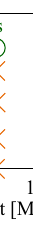
Table 2. Minimum bend radius ratio of steel sheets.